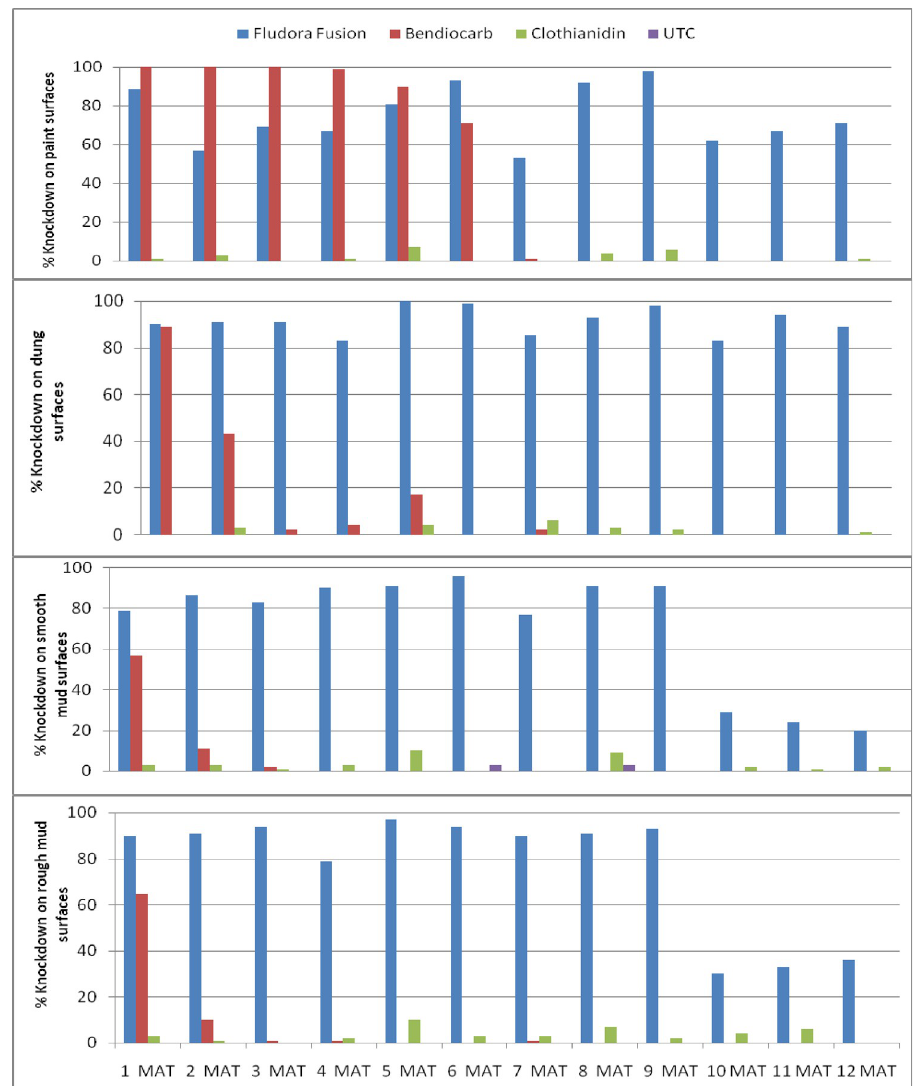
Fig 1. Residual knockdown activity of insecticides, against susceptible Anopheles arabiensis on four surface types of simple huts wall cone bioassays at 60 minutes holding time post-exposure, Ethiopia. MAT: Months after treatment; UTC: untreated